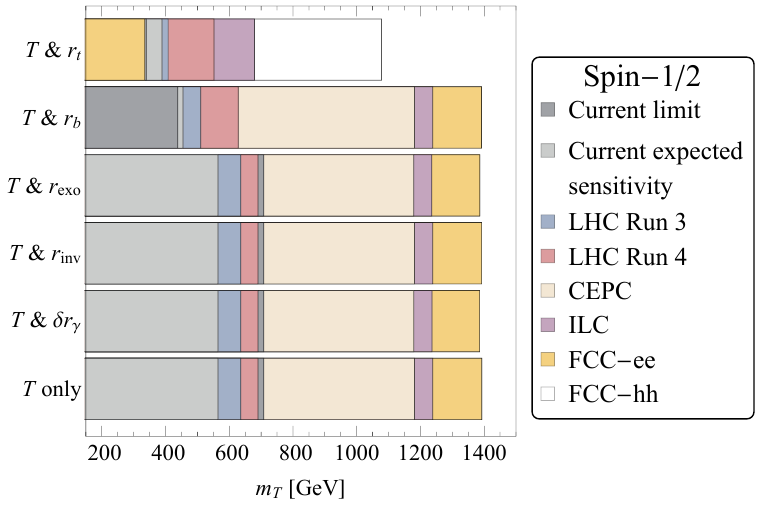
Figure 6 . Similar to (cid:12)gure 5, but here showing excluded parameter space and expected sensitivities at the 2 (cid:27) C.L. on spin-1/2 top partner mass, m T , from various joint-(cid:12)ts of current and future data.